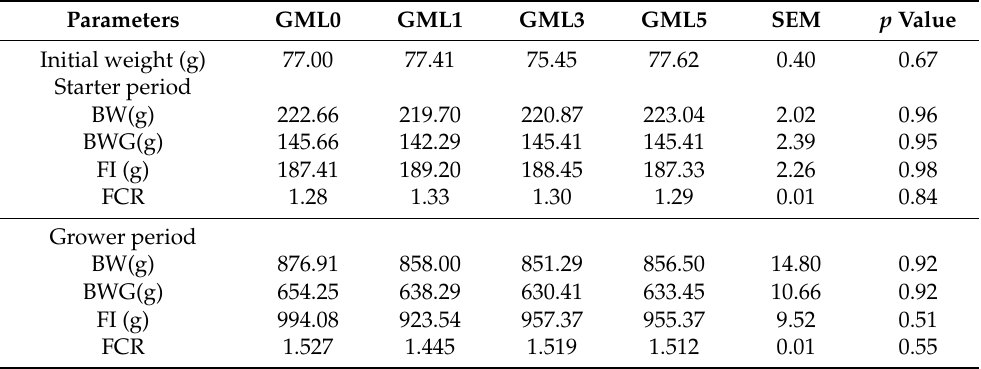
Table 2. The effect of glycerol monolaurate supplementation on the growth performance of broiler chickens.